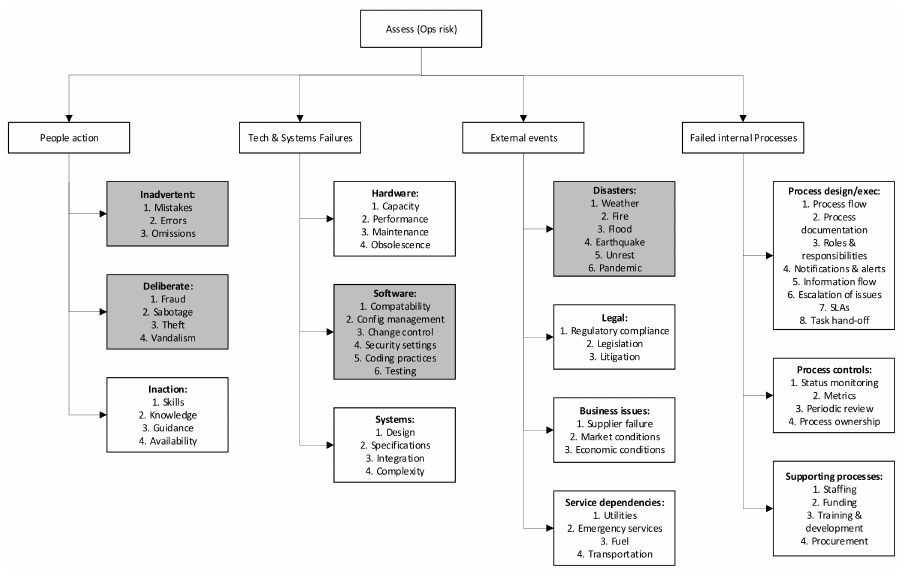
Figure 6. Operational cyber risk taxonomy